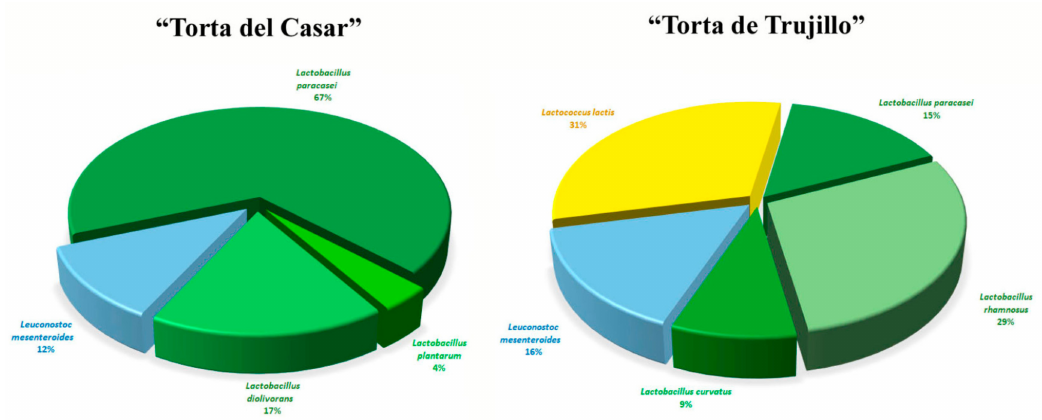
Figure 3. Pie charts showing the distribution of the di ff erent species of LAB in the two cheeses type “Torta” analysed in this